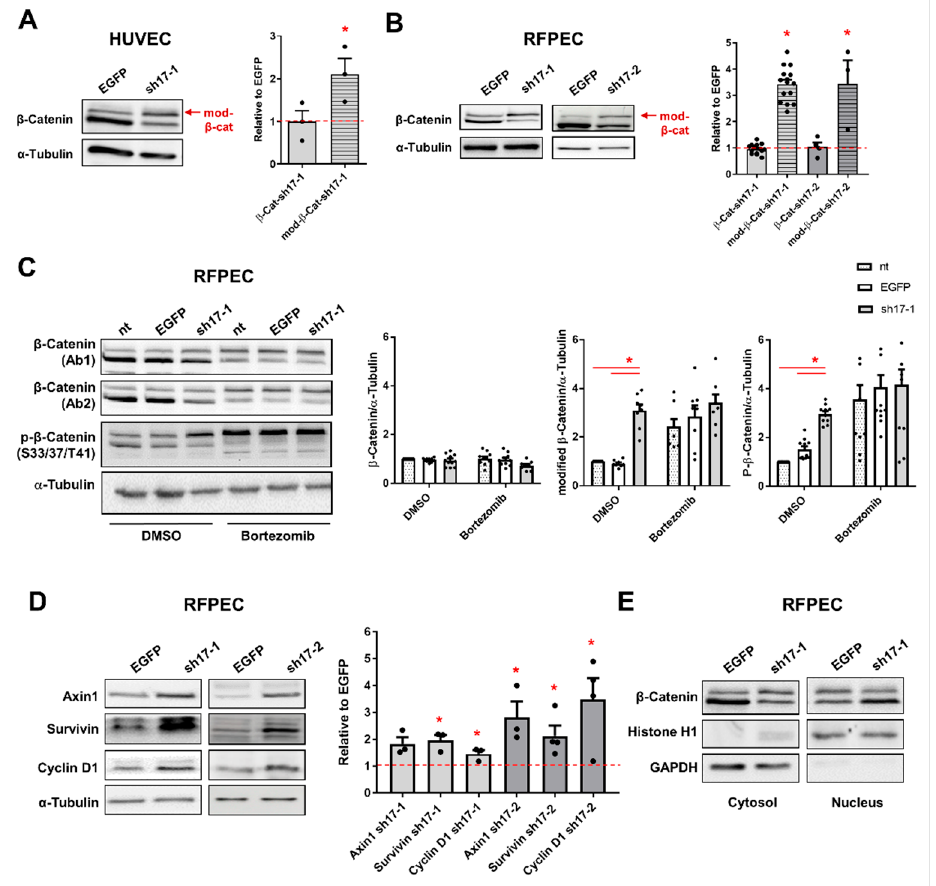
Figure 3. Loss of RhoGEF17 results in the accumulation of phosphorylated β -catenin and increases β -catenin target gene expression in EC. ( A ) HUVEC or ( B ) RFPEC were transduced for 48 h. Representative immunoblots of β -catenin and α -tubulin are shown. The intensity of both detected β -catenin bands ( β -cat) as well as the intensity of the upper β -catenin band (mod- β -cat) were quantified and normalized by α -tubulin. The values are given relative to the EGFP control as means + SEM with the single data points, n = 3 (HUVEC), n = 3–14 (RFPEC), * p < 0.05 vs. EGFP control (not shown) assessed by paired t-testing. ( C ) The proteasome was inhibited with 100 nM Bortezomib for 2 h in RFPEC. β -catenin and phosphorylated β -catenin were detected by immunoblot. Shown are representative immunoblots of β -catenin (Ab1 = Santa Cruz, Ab2 = Zymo Research), p - β -catenin (S33/37/T41) and α -tubulin (left) and the quantitative analyses. The values are normalized and given as means + SEM with the single data points, n = 8–11, * p < 0.05 assessed by 2-way ANOVA with Tukey’s multiple comparison test. ( D ) Axin1, survivin, cyclin D1 and α -tubulin were detected by immunoblot in RFPEC lysates. Shown are representative immunoblots (left) and the corresponding analyses. The values are given relative to the EGFP control as means + SEM with the single data points, n = 3, * p < 0.05 vs. EGFP control (not shown) assessed by paired t-testing. ( E ) Cell fractionation experiments were performed with transduced RFPEC. β -catenin, histone H1 and GAPDH were detected by immunoblot in different cell fractions.